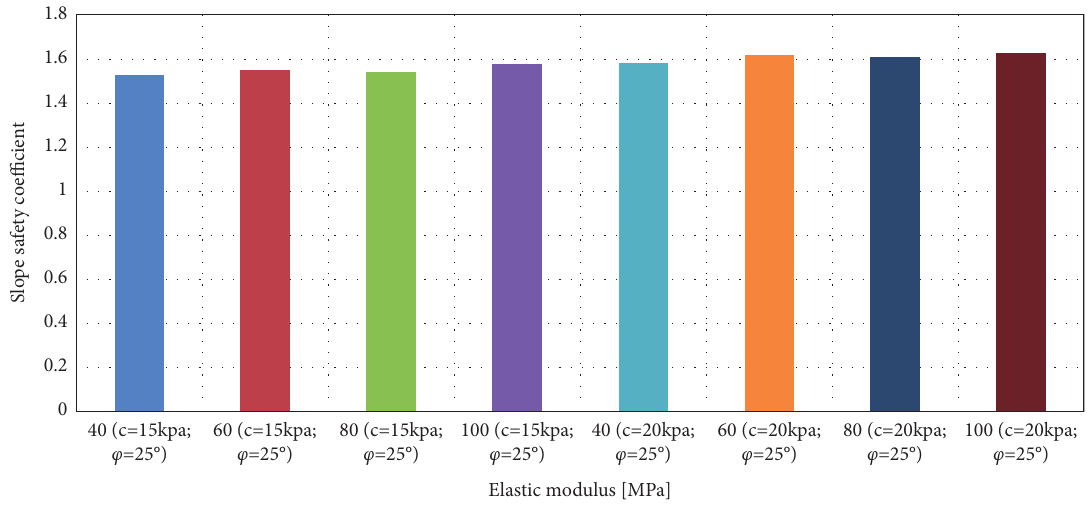
Figure 8: Safety coefficients of the road slope when the cohesion was 15kPa and